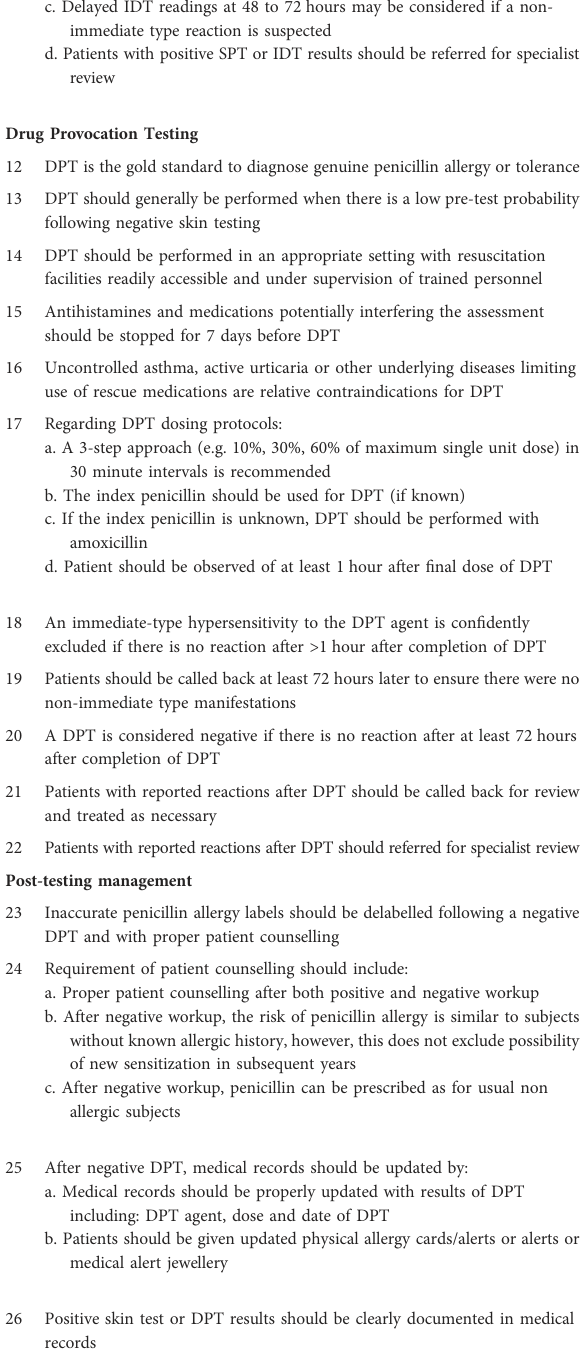
TABLE 1 Summary of consensus recommendations for penicillin allergy testing by